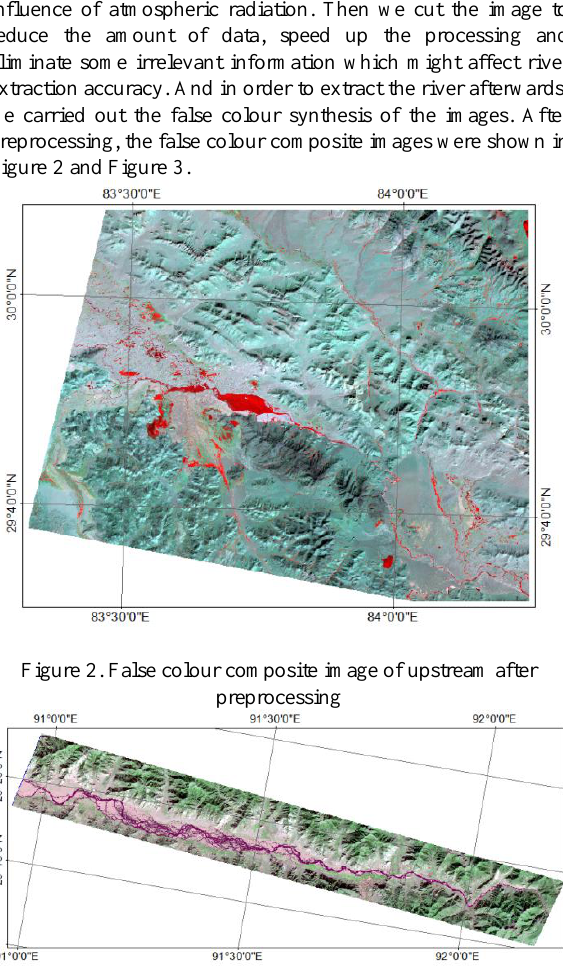
Figure 3. False colour composite image of midstream after